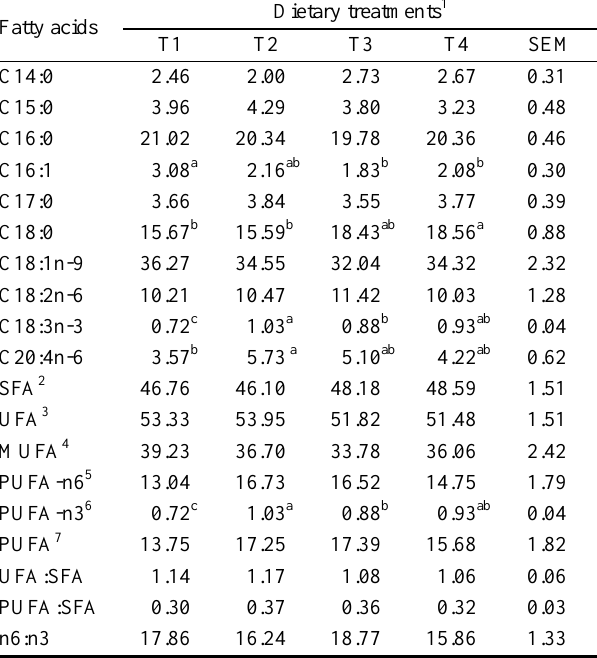
Table 5. Fatty acid composition (% of total identified fatty acids) of the intramuscular fat from the semitendinosus muscle in goats fed experimental